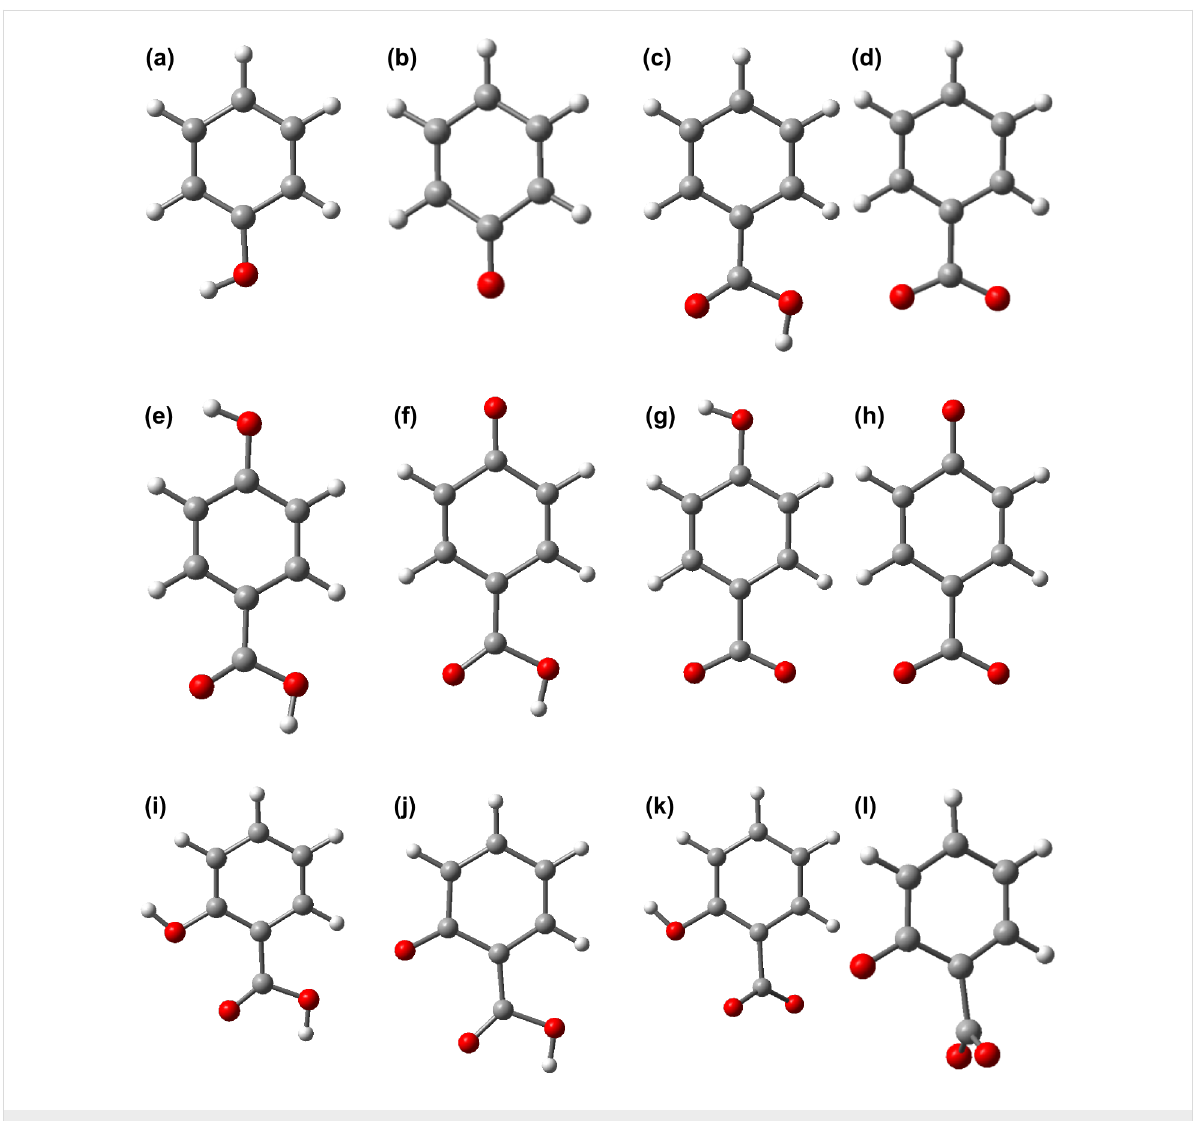
Figure 1: Optimized structure of pollutants in neutral and deprotonated forms calculated at DFT/B3LYP/DZVP level: a) neutral and b) deprotonated Ph, c) neutral and d) deprotonated BA, e) neutral, f) and g) deprotonated, h) doubly deprotonated pHBA, i) neutral, j) and k) deprotonated, l) doubly deprotonated